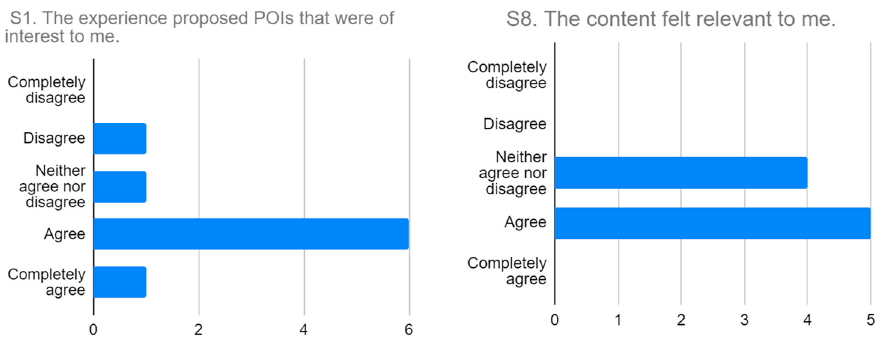
Figure 6. Responses to the questionnaire statements S1 ( left ) and S8 ( right ).